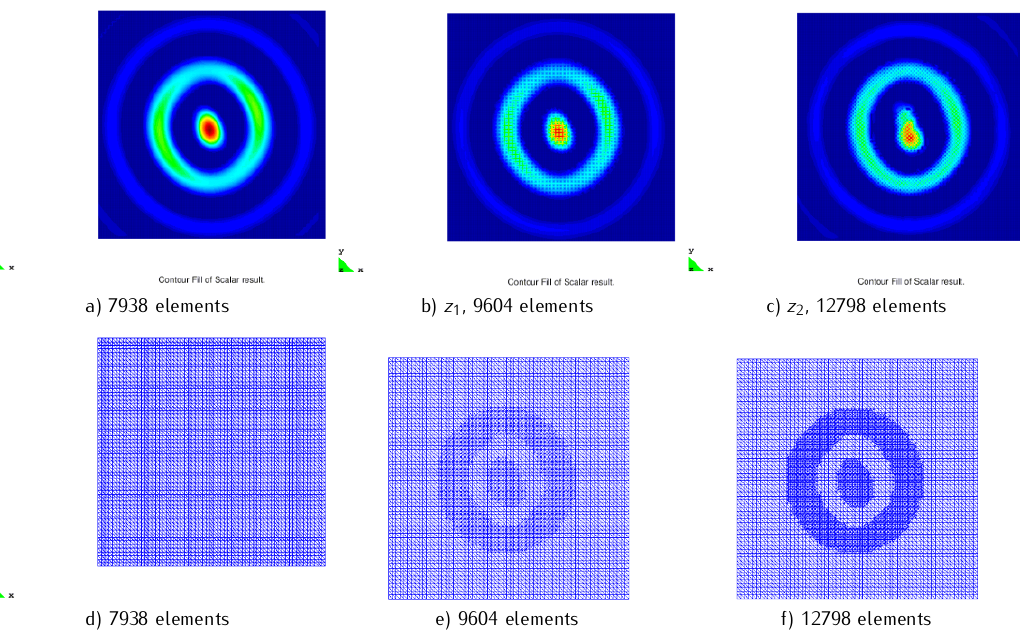
Figure 2. Test 1-b). Reconstruction of the function z ( x 1 ,x 2 ) using simulated backscattered data. In a) we present simulated backscattered data u ( ξ,η ) . In b)–f) we show results of the reconstruction of the function z ( x 1 ,x 2 ) on the different adaptively refined meshes using the second